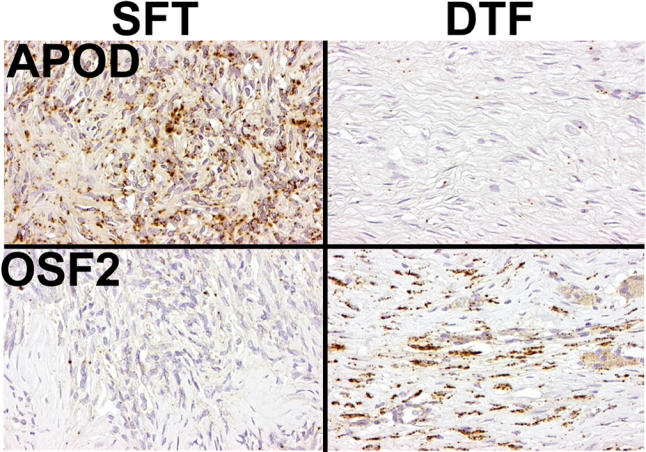
Tissue samples at 600× magnification show that these two soft tissue tumors express different protein markers: solitary fibrous tumors express the APOD protein marker (top), and desmoid-type fibromatosis tumors express OSF2